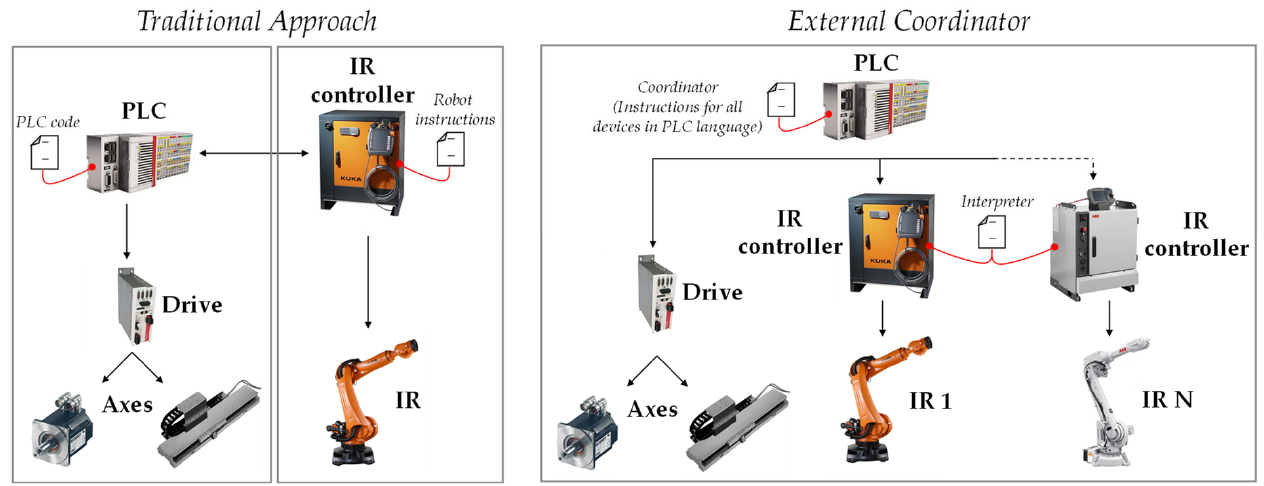
Figure 3. Traditional framework with multiple parallel controllers vs. approach adopting a central- ized PLC coordinator to control the production plant.